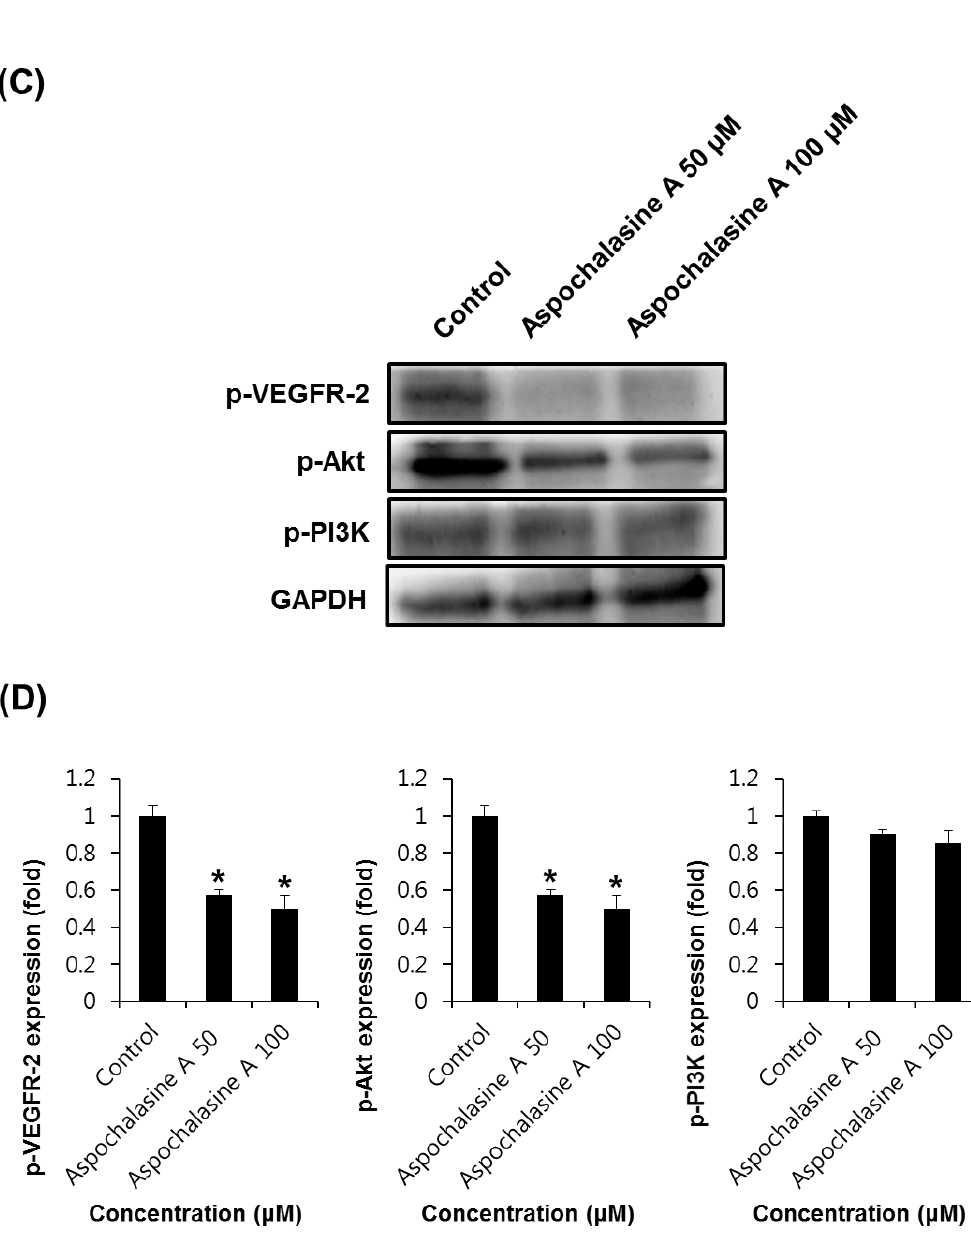
Figure 7. The effect of Aspergillus extract and aspochalasine A on VEGFR-2 and PI3K/Akt signaling in HUVECs. ( A , C ) Western blot indicating the levels of phosphorylated VEGFR-2 (230 kDa), VEGFR-2 (210 / 230 kDa), phosphorylated Akt (60 kDa), and phosphorylated PI3K (85 kDa) in HUVECs treated with Aspergillus extract and aspochalasine A at di ff erent concentrations for 24 h. ( B , D ) Graphs representing quantification of e ff ect of Aspergillus extract and aspochalasine A on the angiogenic protein expressions in HUVECs. Data are expressed as mean ± SEM. Similar results were obtained in three independent experiments; * p < 0.05 compared to the control value.